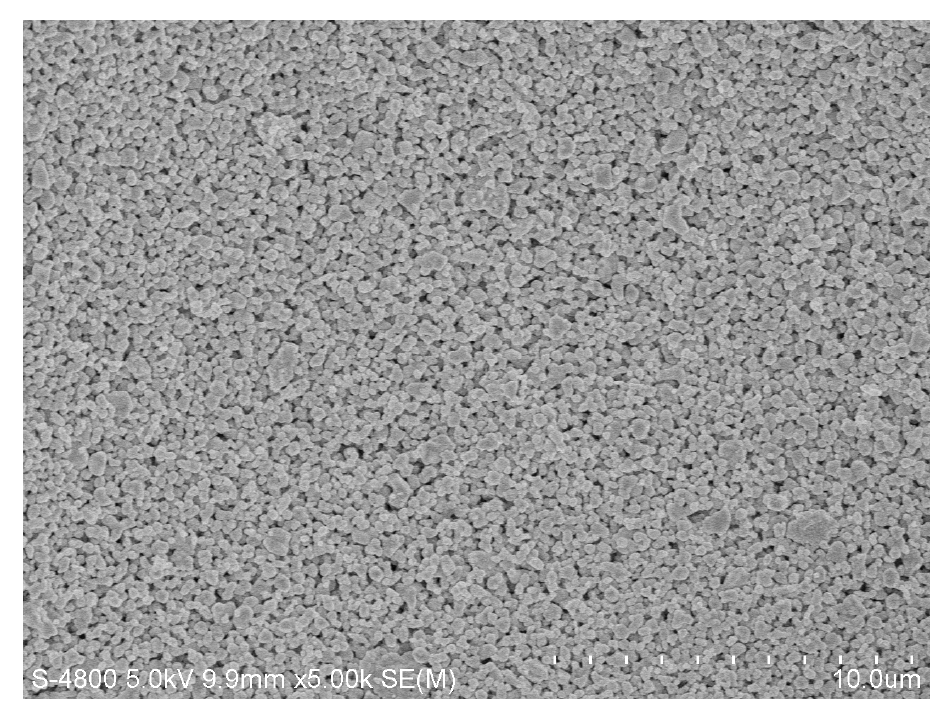
Figure 6. Photograph of the ZrO